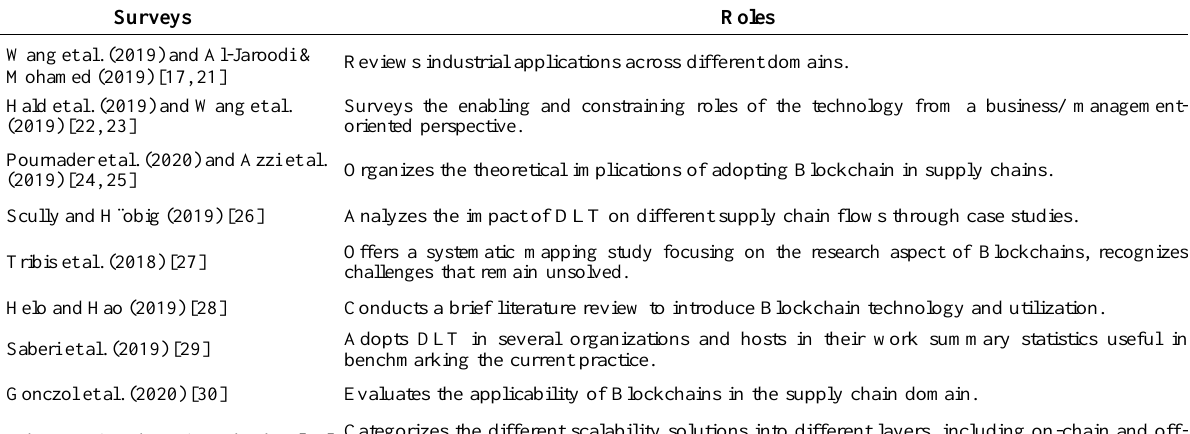
Table 1. Existing surveys on DLT-based supply